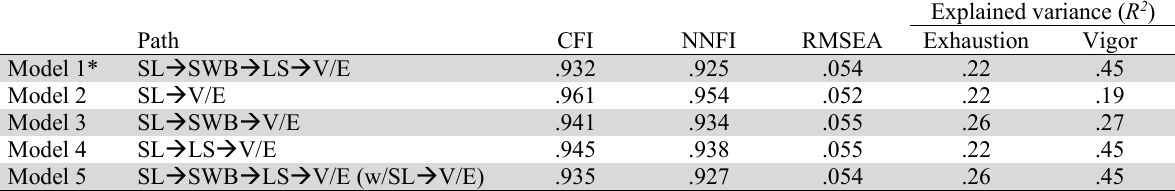
Alternative structural